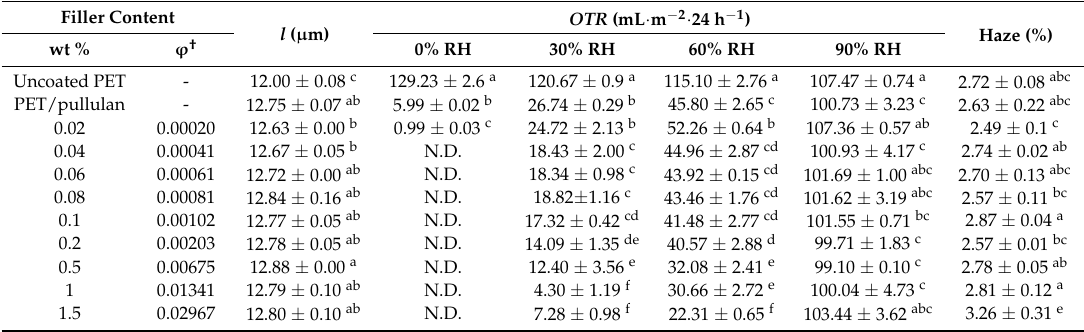
Table 1. Oxygen transmission rate ( OTR ) data for uncoated poly(ethylene terephthalate) (PET) film and PET coated with pullulan/graphene oxide (GO) bionanocomposite coatings at different filler volume fractions ( ϕ ) for different relative humidity (RH)